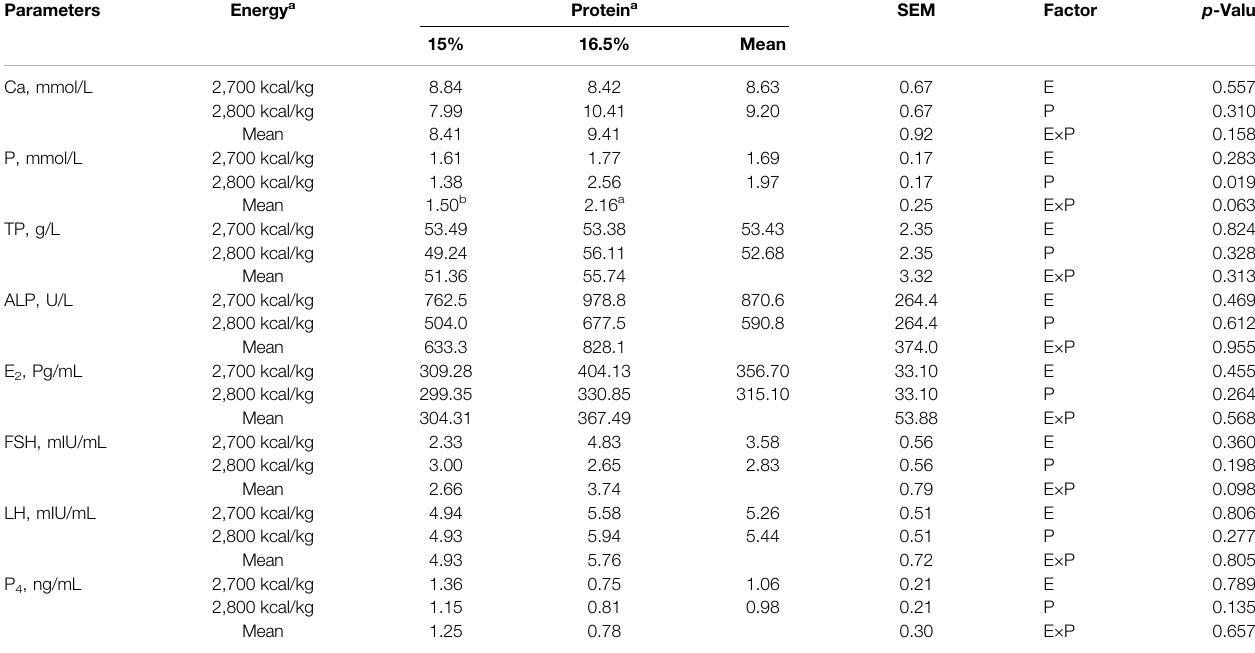
TABLE7| Effectofdietarymetabolizableenergy(E)andcrudeprotein(P)levelsduringtheprelayperiod(15 – 20weeksofage)onserumparametersinlayinghensat72 week of age.